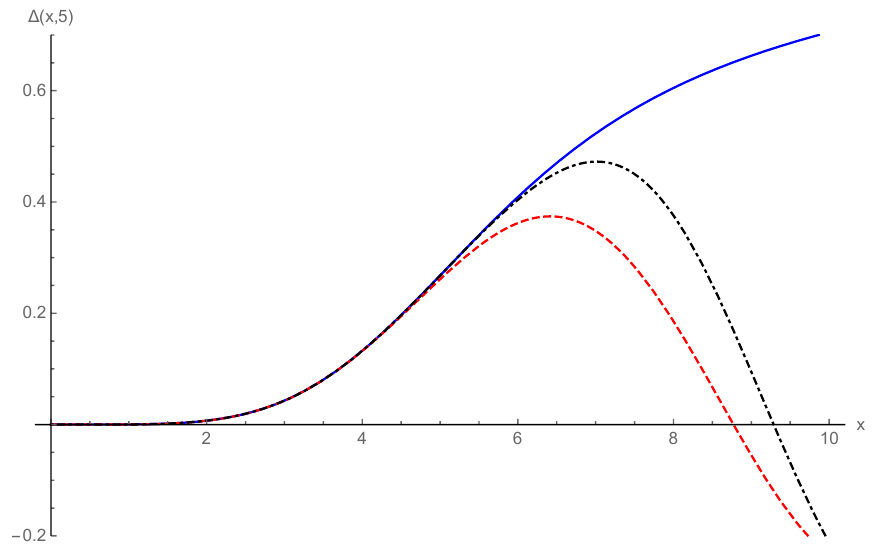
Figure 5 . Comparison plots of the exact (cid:1)( x; N ) [solid blue curve] as a function of x , with N = 5, compared to the inclusion of successive terms in the strong-coupling trans-series expansion (5.10), with (cid:24) (cid:1) taking its physical value: (cid:24) (cid:1) = 1. The agreement is excellent in the strong-coupling strong strong x ! 0 region, and also in the transition region x (cid:25) N , and improves progressively as more terms in the instanton sum are